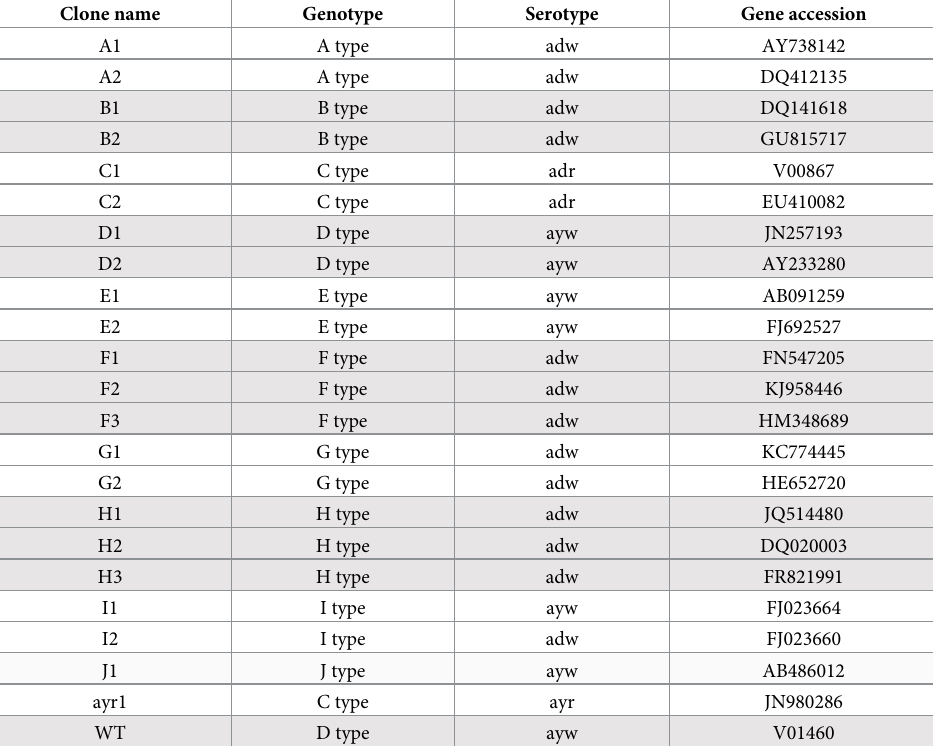
Table 1. S gene clones of HBV genotypes investigated in this